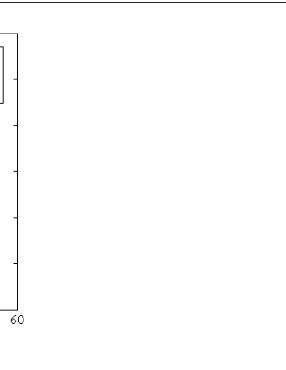
Fig. 5. Plot of piercing force-displacement traces. Comparison between the three